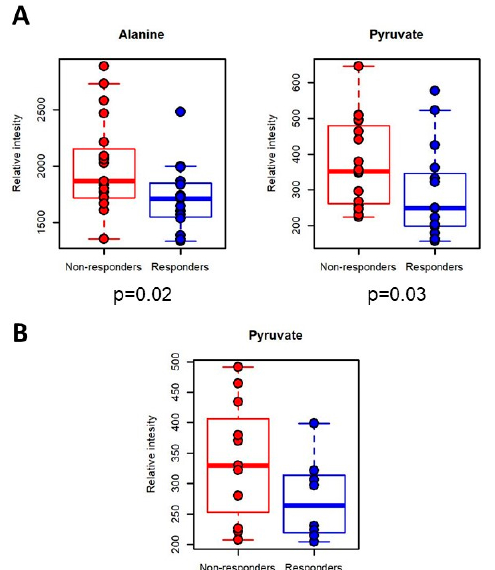
Figure 4. Metabolites analysis. Box plot of the serum levels of the significantly di ff erent metabolites for the comparison between responders and non-responders in ( A ) nivolumab-treated patients; ( B ) pembrolizumab-treated patients.